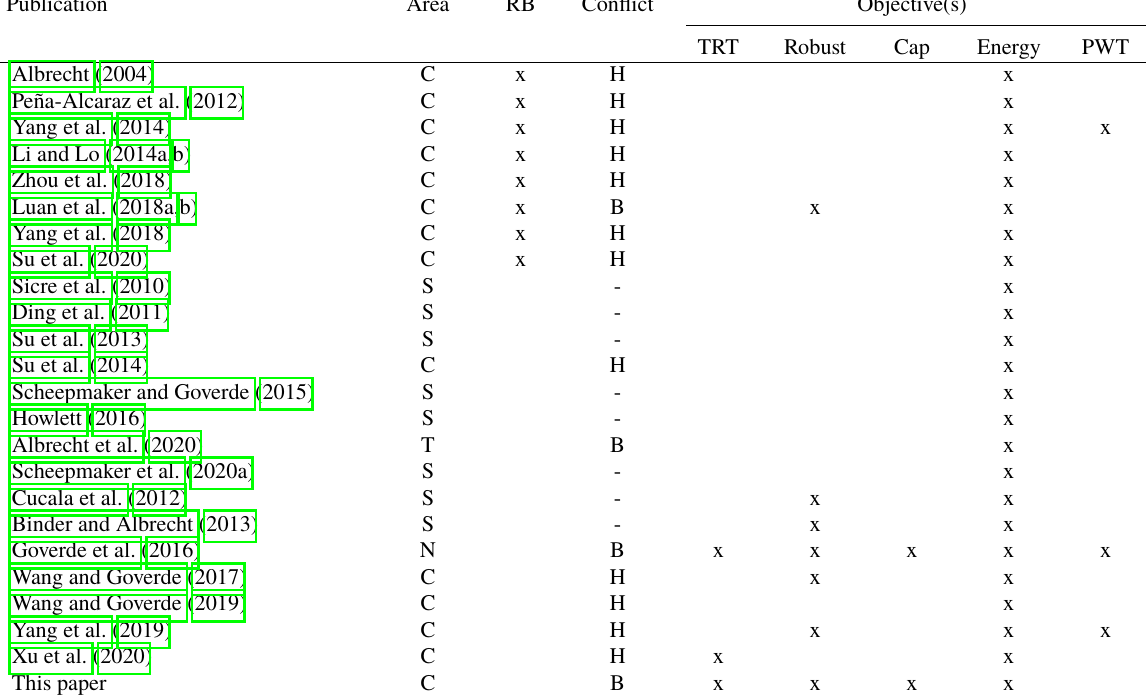
Table 1: Summary of EETT